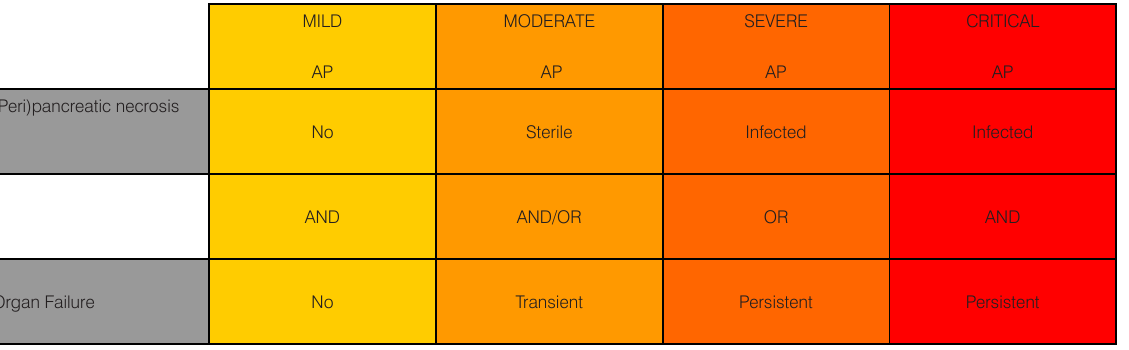
Table 4. Comparison of Classification Schemes of AP: Atlanta Classification vs Working Group Classification vs Determinant-Based Classification Atlanta Classification Working Group (Banks 2012.Gut) (Bradley.1993.Arch Surg)